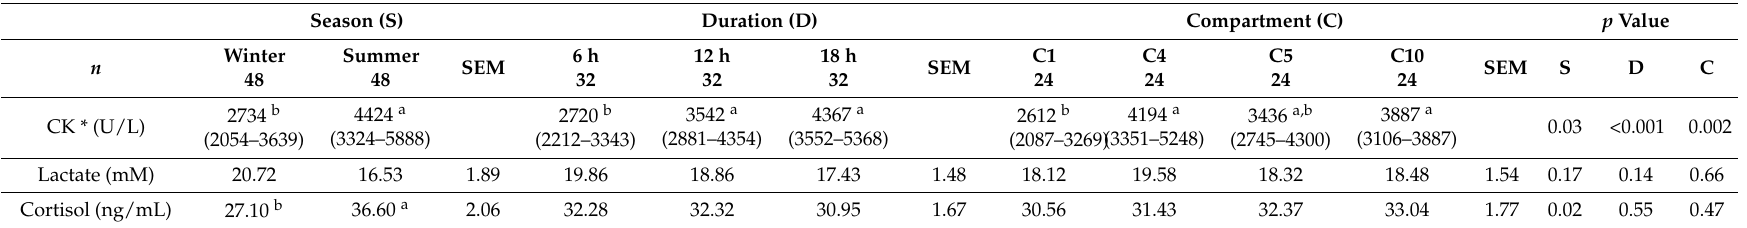
Table 1. Variation in blood lactate, creatine kinase (CK) and cortisol concentrations by season (winter and summer), travel duration (6, 12 and 18 h) and trailer compartment location (C1, C4, C5 and